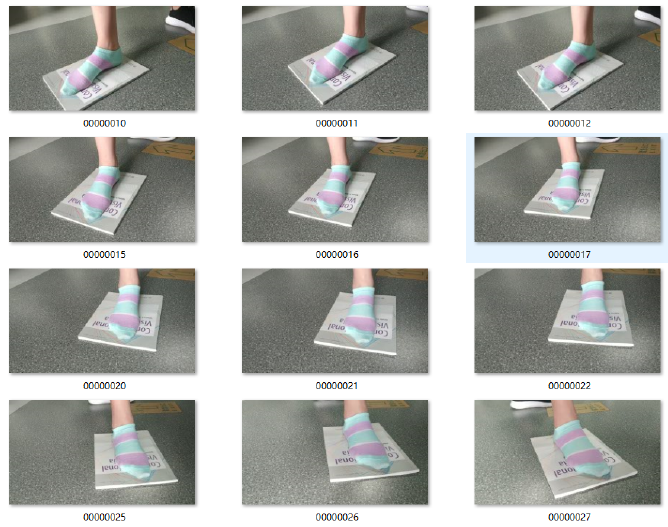
Figure 4. The part of the foot